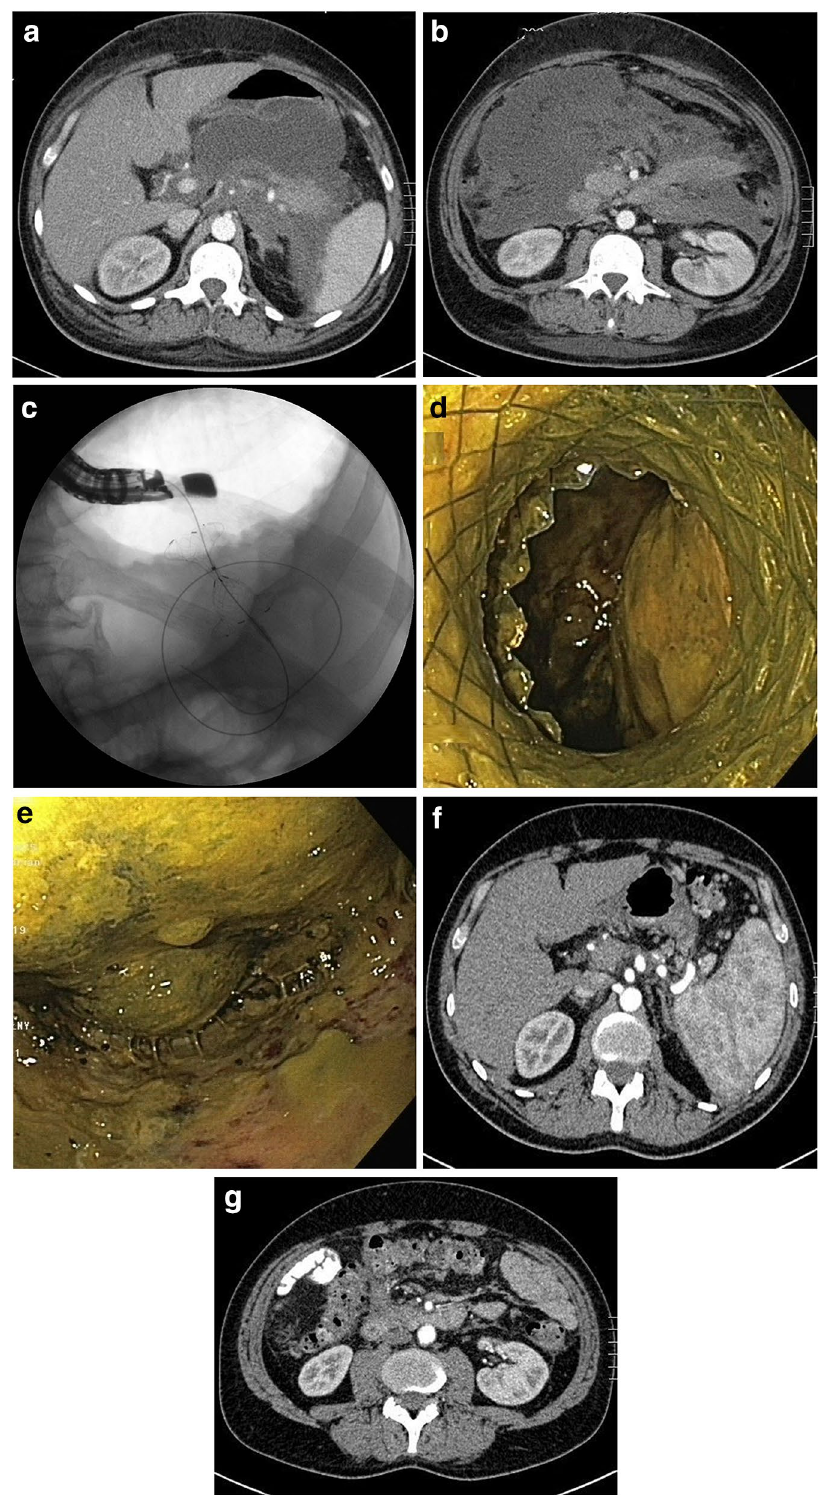
Figure 1. a – g Endoscopic treatment of acute necrotic collections. A 35-year-old male with acute necrotizing pancreatitis. On contrast-enhanced abdominal and pelvic computed tomography on day 8 of pancreatitis, extensive acute necrotic collections are visible ( a , b ). Because of symptoms of abdominal compartment syndrome, transmural endoscopic drainage of acute necrotic collections was performed. On fluoroscopy, the drainage system can be seen ( c ). During direct endoscopic debridement, solid necrotic masses within the lumen are visible ( d , e ). On control multiphase contrast-enhanced abdominal and pelvic computed tomography ( f , g ) after 6 months since the endoscopic treatment, complete regresion of necrotic collections was